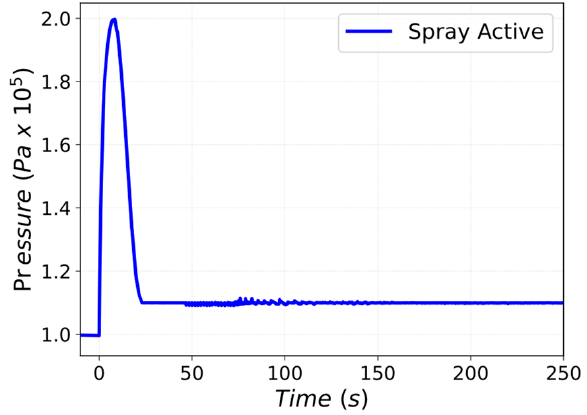
Figure 26. Pressure in the UPC.